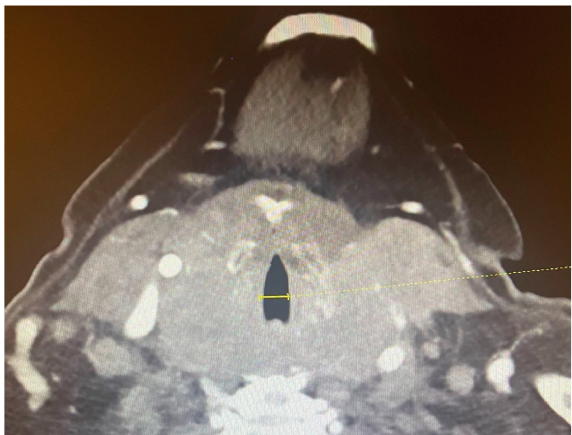
Figure 1: CTneck scan with contrast showed a markedly enlarged bilateral thyroid gland measured approximately 7.8 × 7.2cm, with marked transverse narrowing of the trachea at the level of the thyroid gland to approximately 8.6mm (solid yellow line).